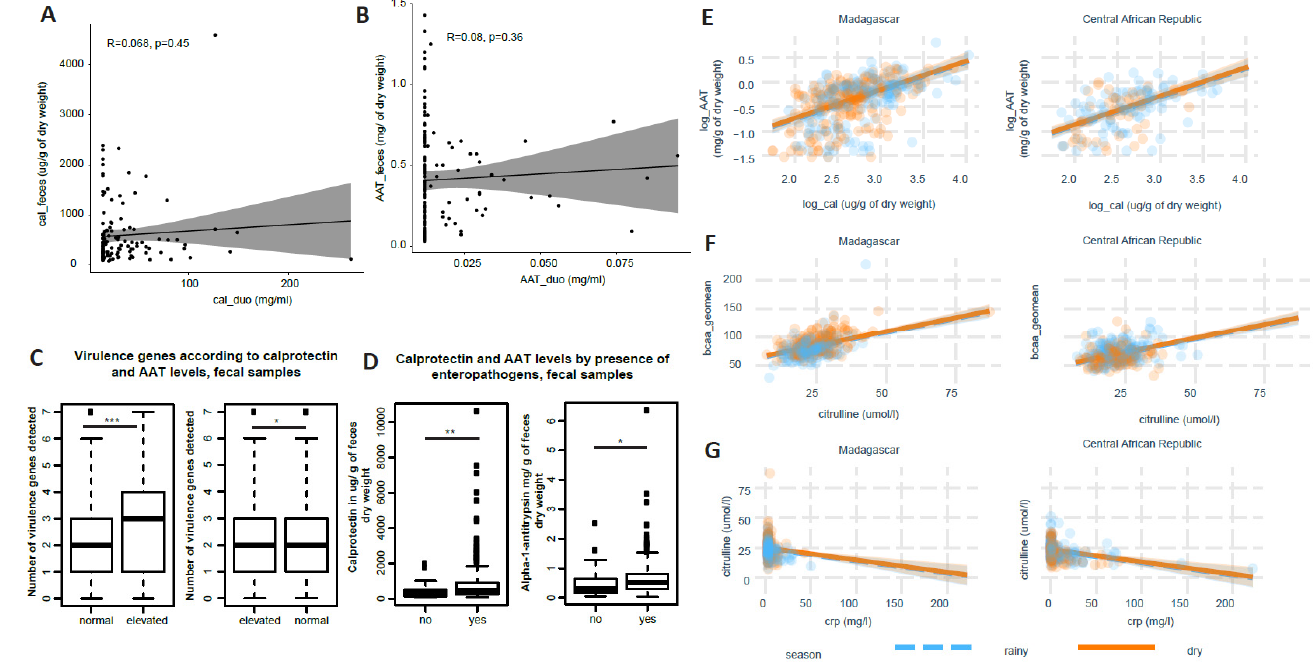
Figure 2. Correlation of different biomarkers between body compartments, with each other as well as with the number of virulence genes: ( A ) correlation plot of calprotectin levels in feces and duodenum; ( B ) correlation plot of alpha-1-antitrypsin (AAT) levels in feces and duodenum; ( C ) number of enteropathogenic virulence genes detected according to calprotectin and AAT levels; ( D ) calprotectin and AAT concentration measured in the feces depending on the presence of at least one virulence gene measured by qPCR; ( E ) correlation of levels of fecal calprotectin and AAT levels; ( F ) correlation of citrulline levels and the geometric mean of branched-chain amino acids (BCAA = isoleucine, leucine, valine); ( G ) correlation of blood citrulline and CRP levels; correlations are based on non-parametric Spearman correlation; *: p < 0.05; **: p < 0.01; ***: p < 0.001, ns: p > 0.05.